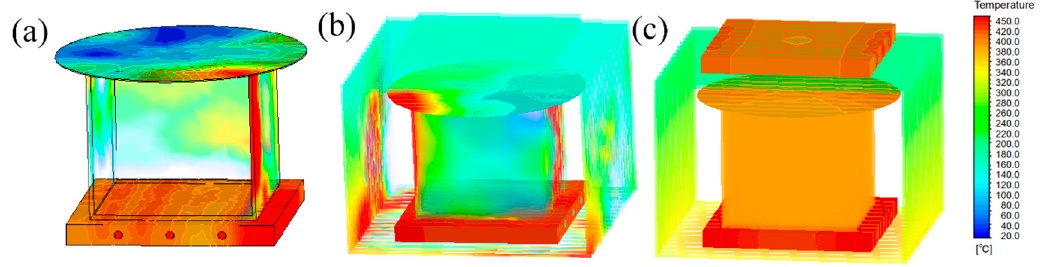
Figure 5. Distribution of temperature with three evaporation methods: ( a–c ) open-type evaporation, closed-type rapid cooling evaporation, and closed-type precise temperature-controlled evaporation. The temperature differences at the center of the sample are 120, 30, and 10 °C.